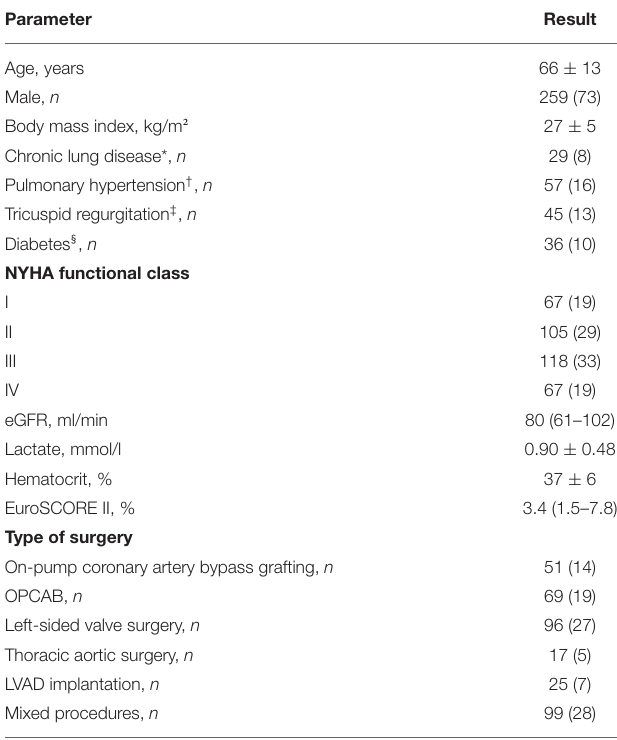
TABLE 1 | Baseline clinical data of the complete patient cohort ( n =